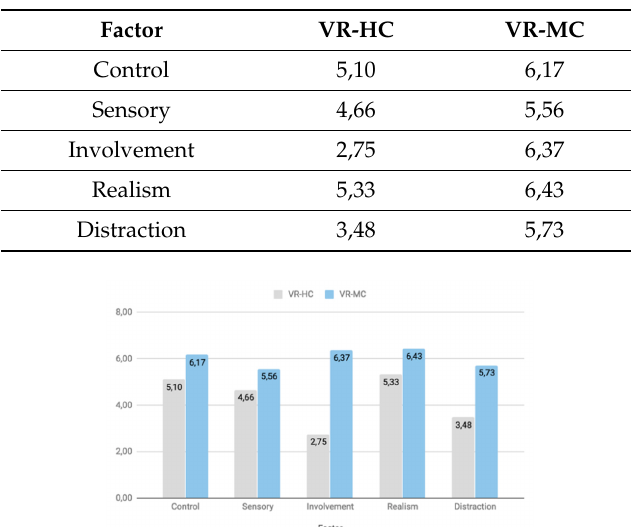
Figure 11. Comparison of the mean of the Control, Sensory, Involvement, Realism, and Distraction Factors between the VR-HC and VR-MC systems. Factors between the VR-HC and VR-MC